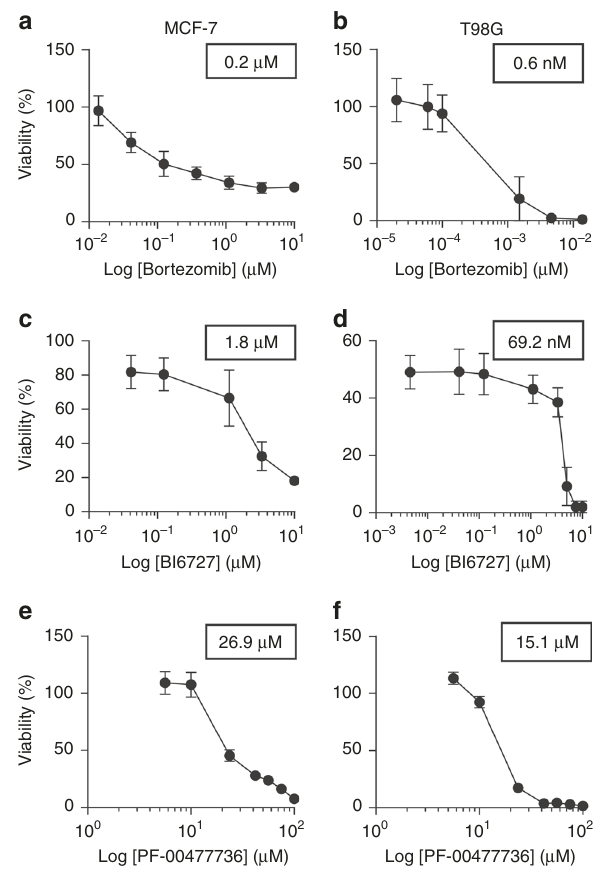
Fig. 4 Cluster 2 cell lines response to Bortezomib, BI6727 and PF- 00477736. MCF-7 and T98G cells were treated with increasing doses of Bortezomib (0.01 – 10 μ M for MCF-7 ( a ), 0.02 – 10 nM for T98G ( b )), BI6727 (0.04 – 10 μ M for MCF-7 ( c ), 0.004 – 10 μ M for T98G ( d ), PF- 00477736 (5.6 – 100 μ M ( e , f )) and cell viability was measured 72 h after drug administration by WST-1 assay (three independent experiments). Cell viability is represented as mean (error bars: s.e.m.). IC50 values are